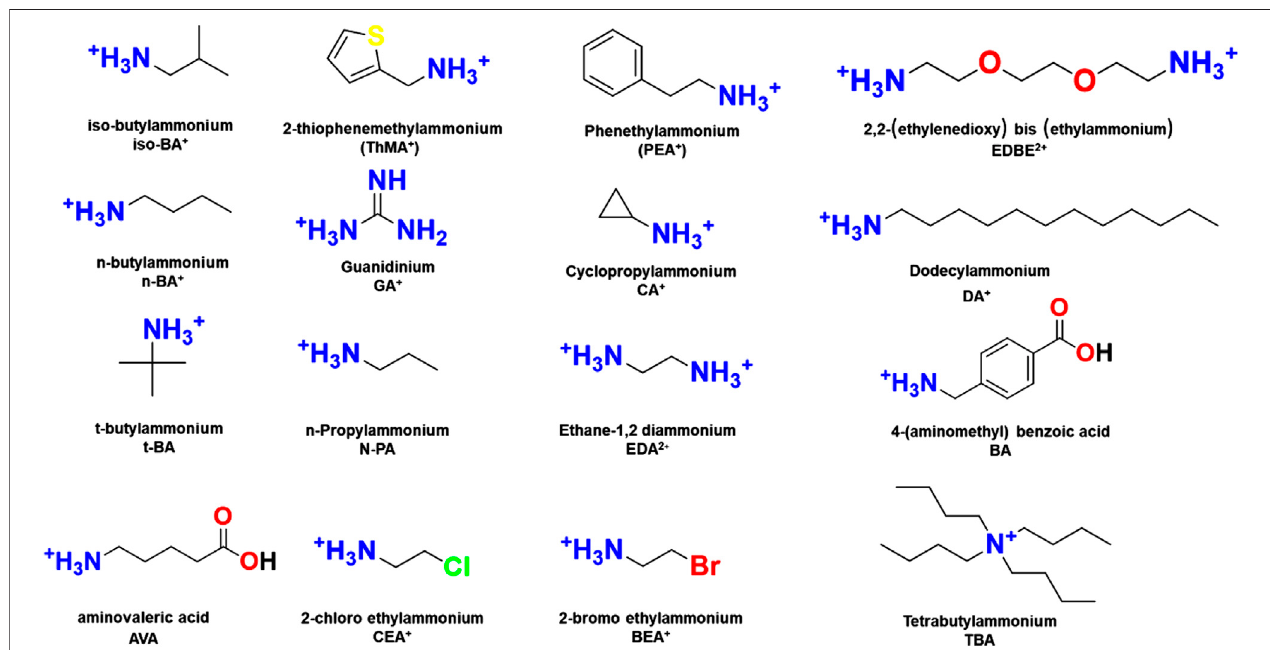
FIGURE 1 | Chemical structure of the reported organic cations employed for the construction of 2D/3D multidimensional perovskites.